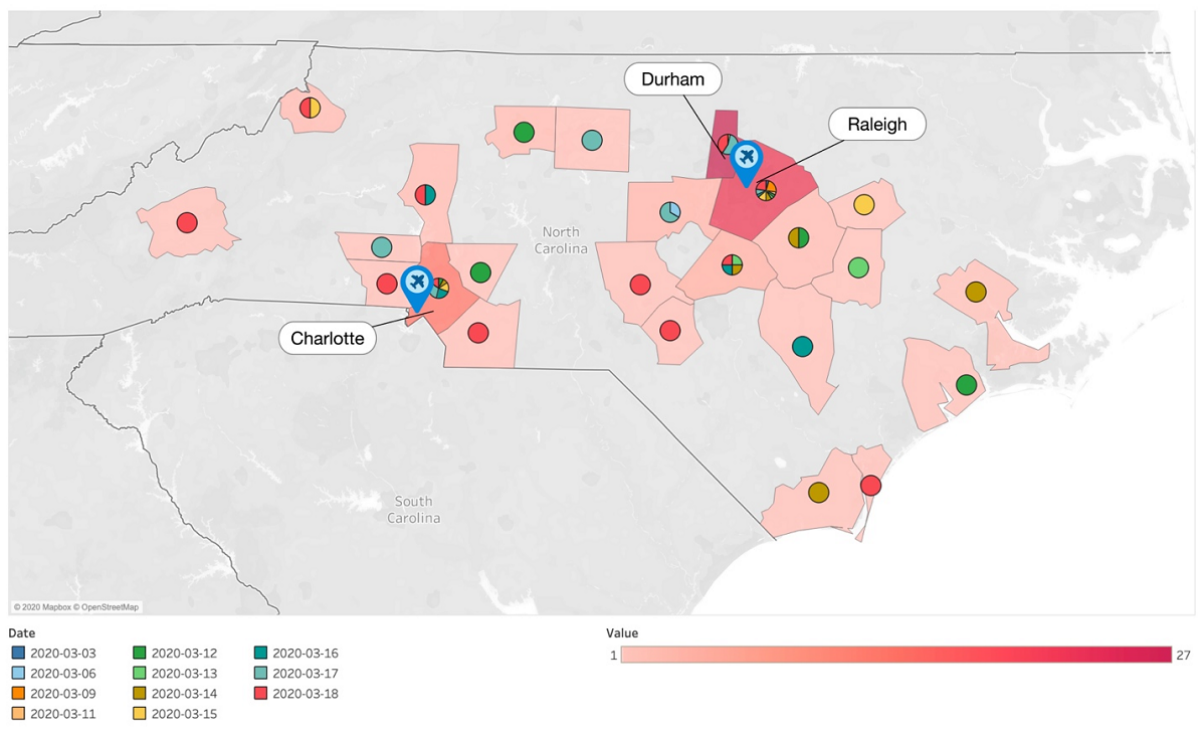
Figure 2. Time-motion analysis of confirmed coronavirus disease cases from March 3 to March 18,